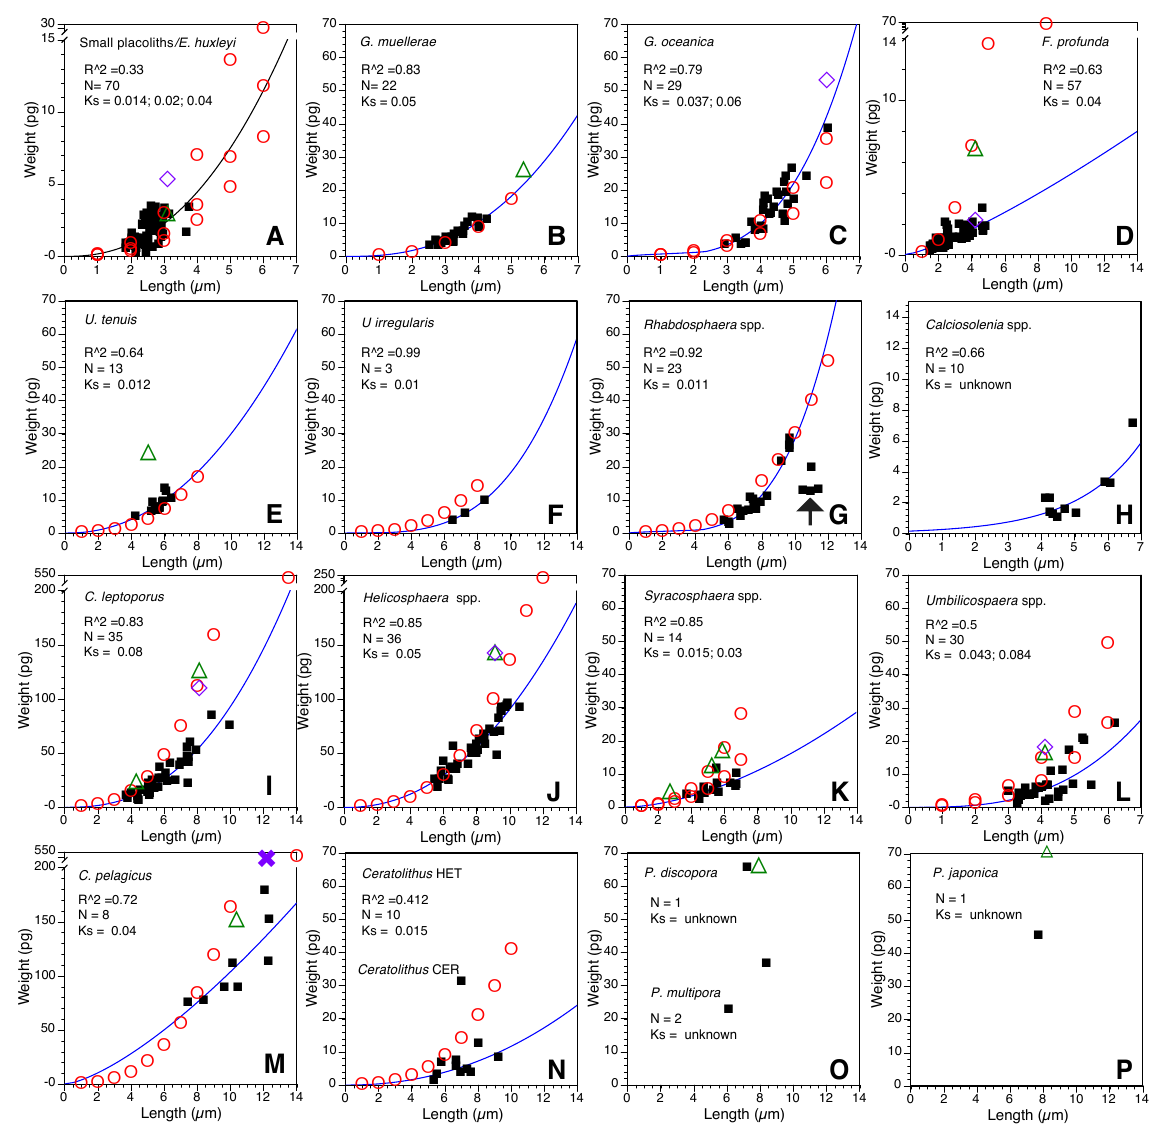
Fig. 3. Comparison between weight estimates of 16 Holocene coccolith taxa obtained with the new method and published values. K s = shape Figure 3 factor introduced by Young and Ziveri (2000); the weight of a coccolith was calculated as follows: Weight = K s × (Length) 3 × 2 . 71 (density of calcite). Minimum and maximum K s values given by Young and Ziveri (2000) were used to calculate the coccolith weights; values for maximum length of coccoliths for E. huxleyi were reported by Bollmann and Herrle (2007), for Gephyrocapsa spp. by Bollmann (1997) and Bollmann et al. (2010), for F. profunda by Quinn et al. (2005), for C. leptoporus by Knappertsbusch et al. (1997), for C. pelagicus by Parente et al. (2004). Values for all other species were taken from Young and Ziveri (2000). The blue line represents a power curve fit. Number of data points (N; black squares) and the correlation coefficient ( R 2 ) for the power fit is given for each species. The arrow in Fig. 3g indicates Rhabdosphaera spp. larger than